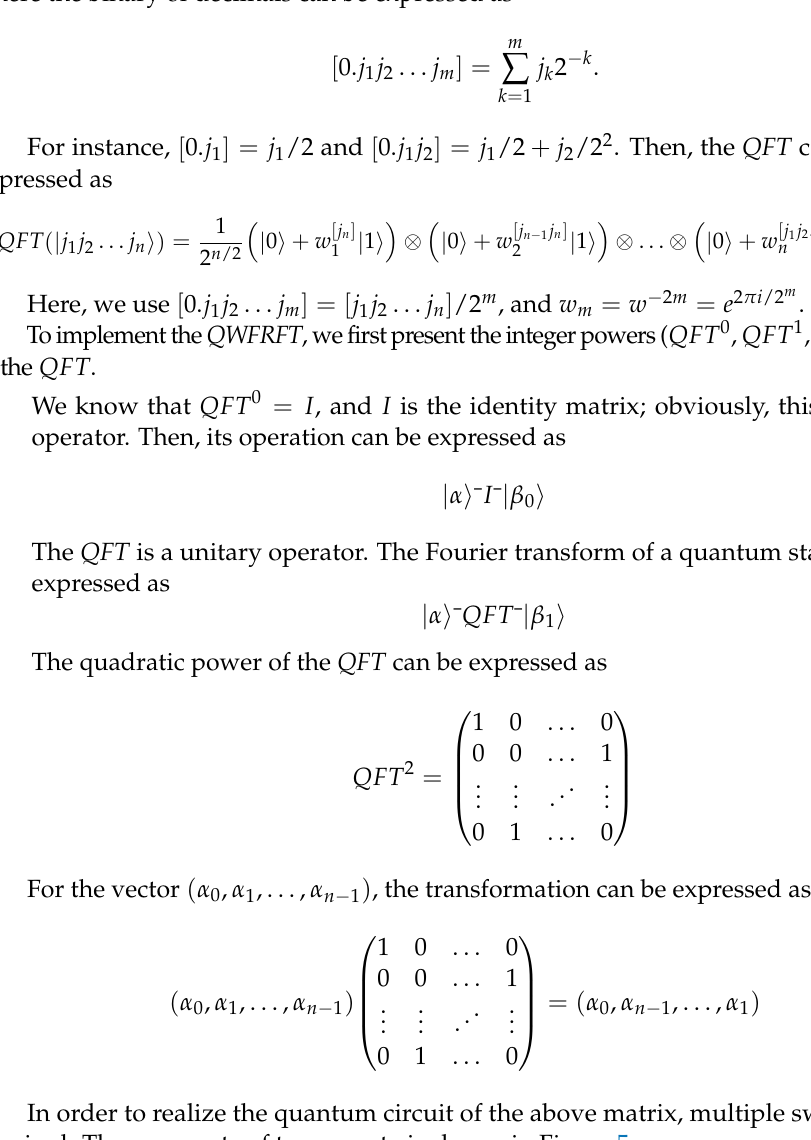
Figure 5. Swap Figure 5. Swap gate.